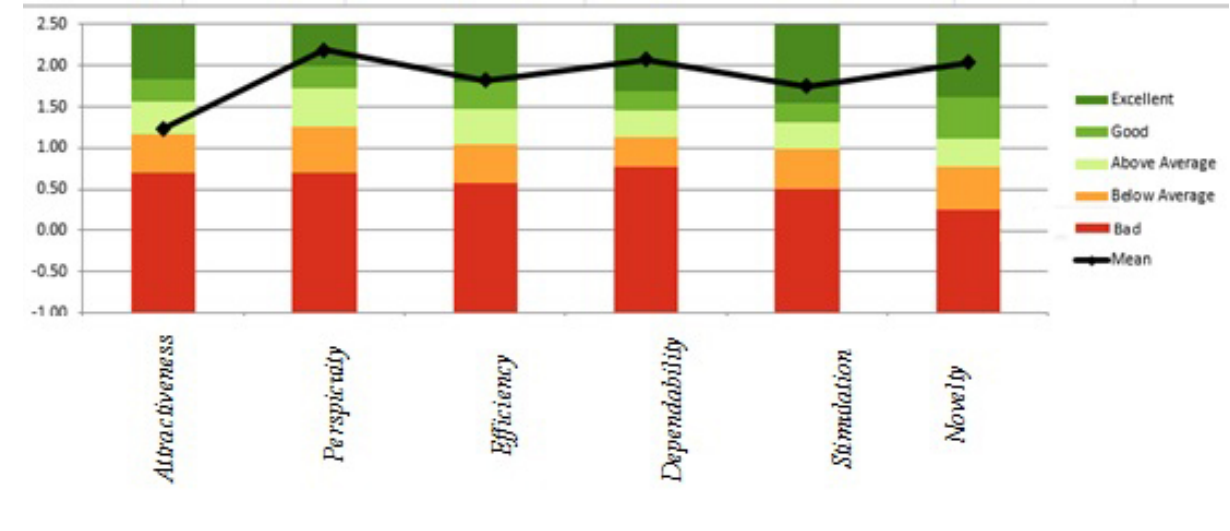
Figure 7. Comparison chart of average web-based system measurements with previous